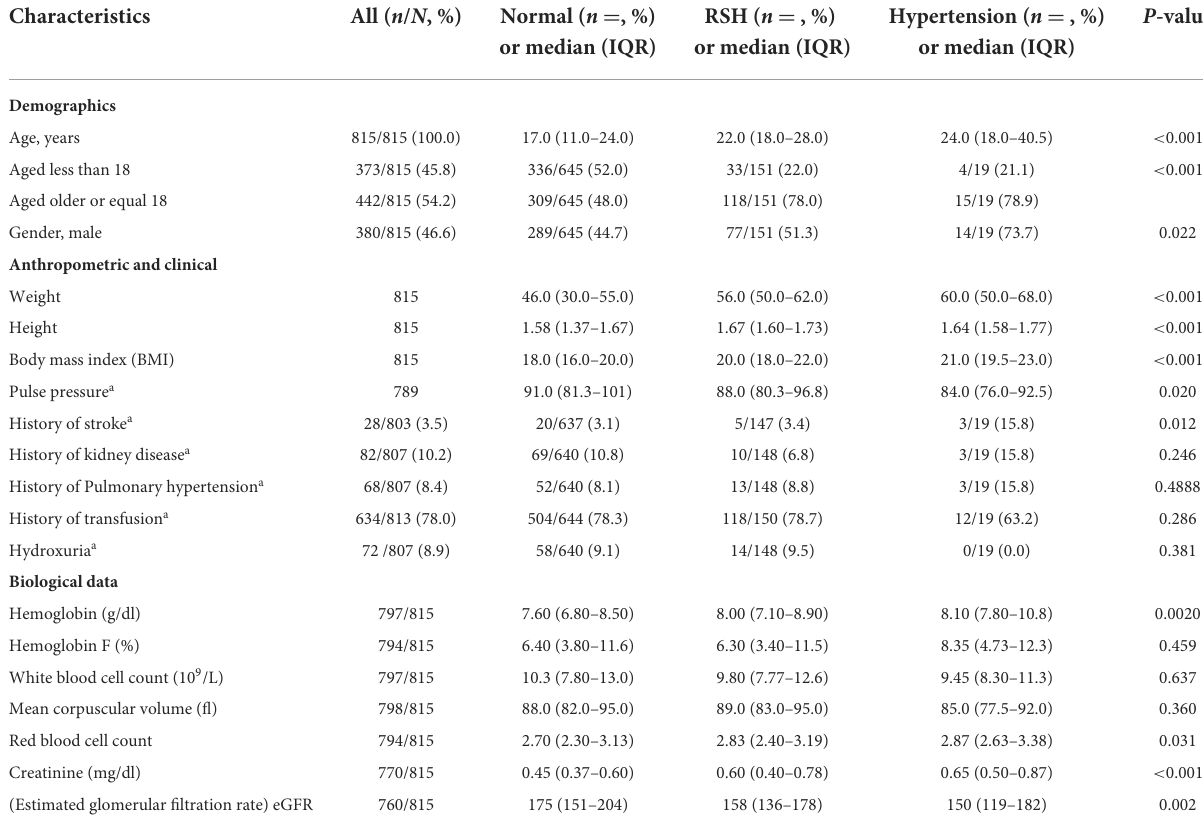
TABLE 1 Baseline demographic, anthropometric, clinical and laboratory characteristics of Cameroonian SCD patients by BP levels.